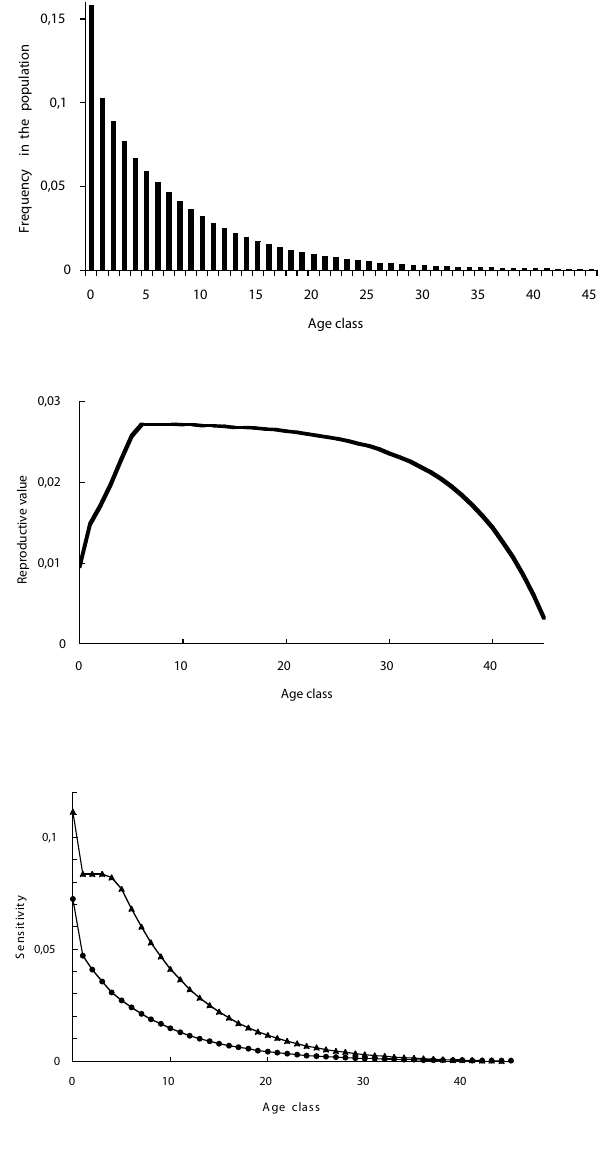
Fig. 8. Sensitivity of lambda to changes in fertility and survival of Baltic grey seals. Triangles indicate survival values, black circles